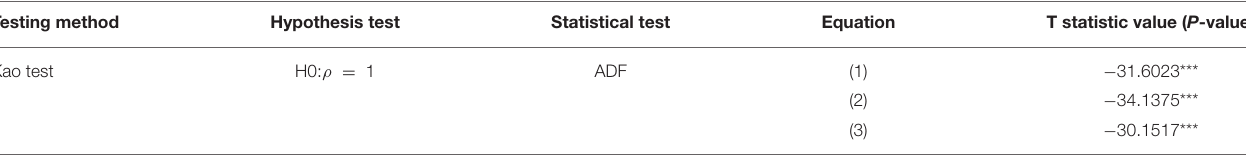
TABLE 4 | Results of cointegration